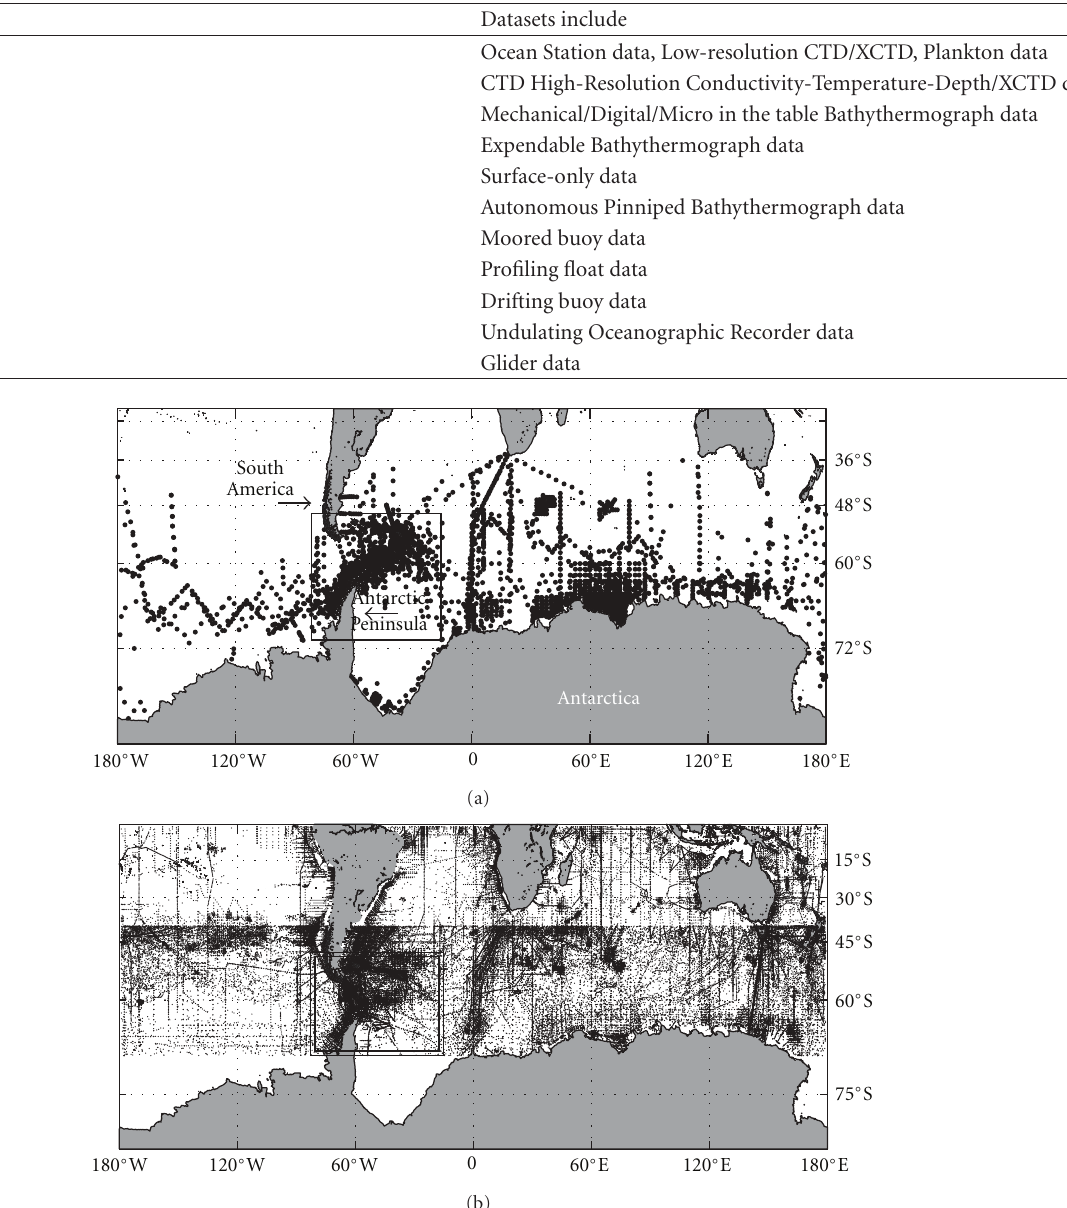
Figure 1: Sampling coverage for Antarctic krill and salps ((a), from [8]) from 1926 to 2002 and physical parameters from WOD01 and WOD05 from 1975 to 2002 (b) in the Southern Ocean. Rectangular boxes represent study area: 50–70 ◦ S and 20–80 ◦